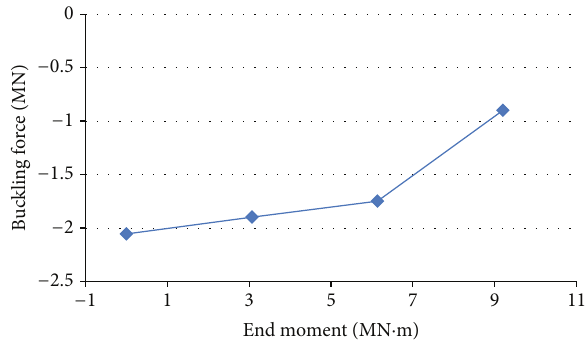
Figure 10: Variation of critical buckling compressive force ( 𝑃 cr ) with end moment ( 𝑀 𝑧𝑧 ) for cantilevered boundary condition.